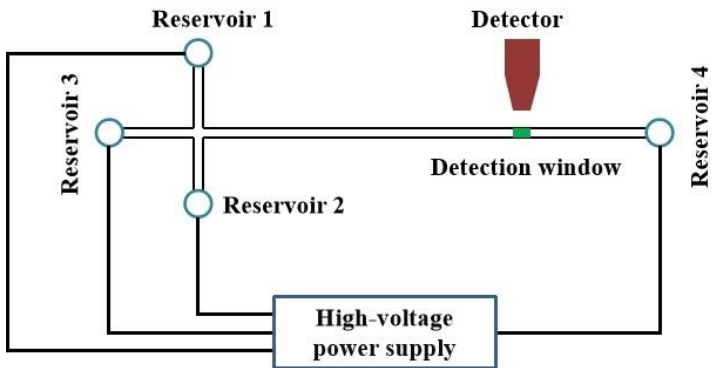
Figure 1. Sketch of the lab-built microchip capillary electrophoresis (CE) system.